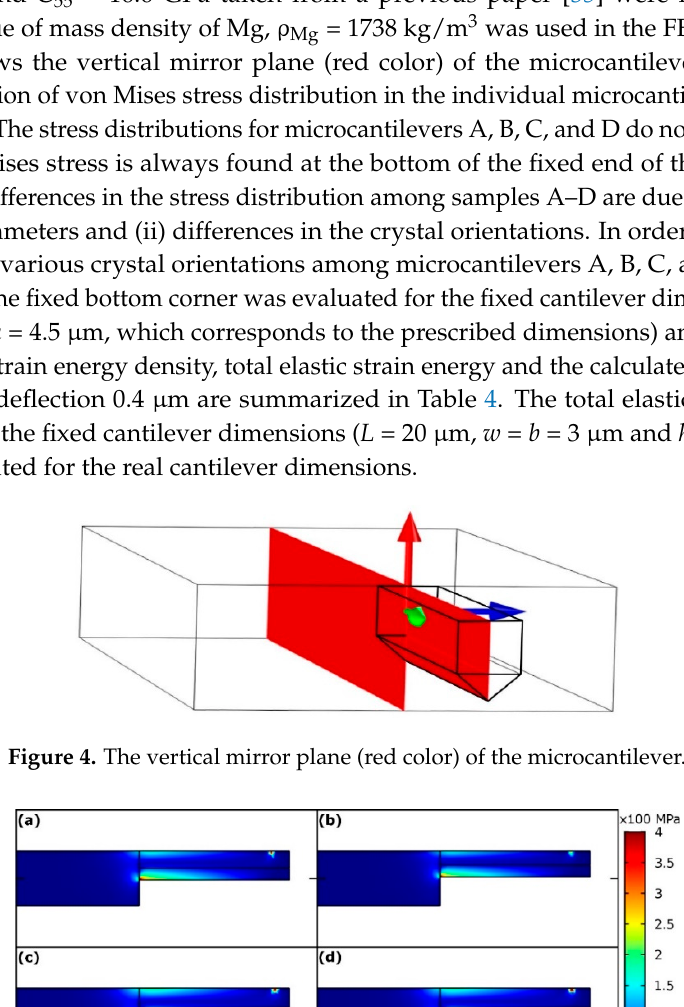
Table 4. The calculated elastic strain energy density in the fixed bottom corner, calculated total elastic strain energy, and the calculated {measured} forces belonging microcantilevers A, B, C, and D, assuming deflection equals 0.4 μ m.